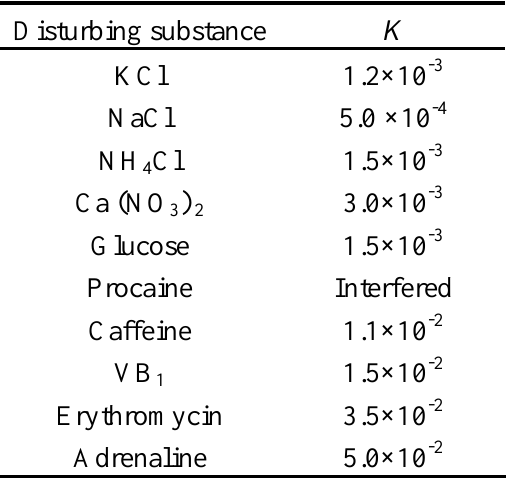
Table 2. The selective coefficients of the sensor (solution-mixing method).